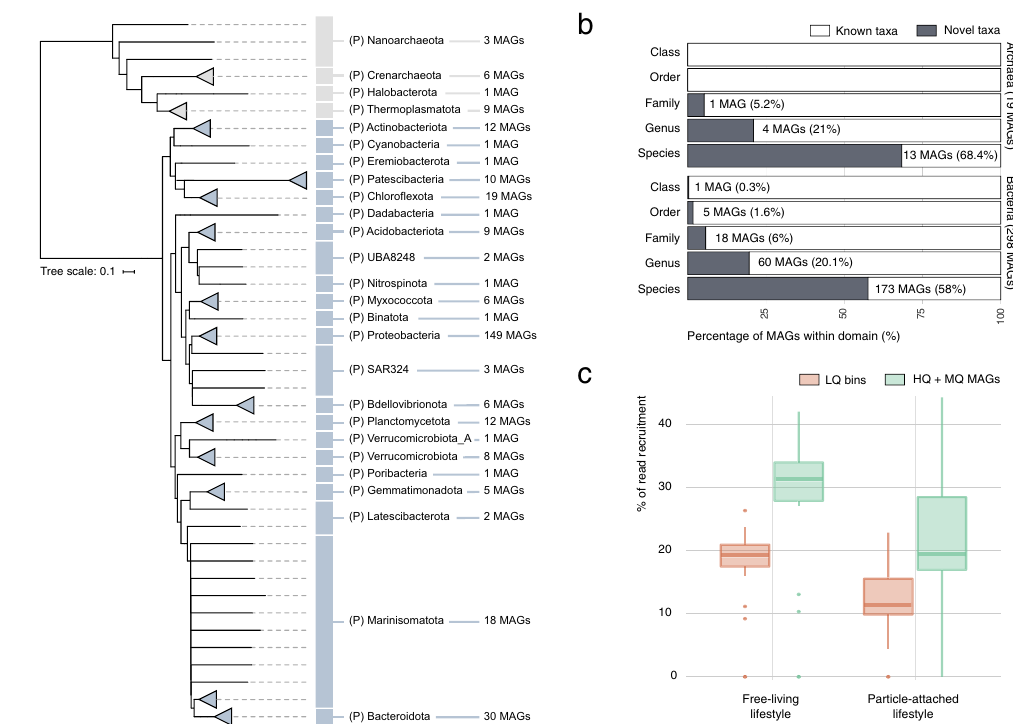
Fig. 5 Taxonomy and novelty of the Malaspina Deep MAGs catalog (MDeep-MAGs). a Phylogenomics-based taxonomic classi fi cation of the 317 MDeep-MAGs (i.e., high-quality bins) dataset obtained from co-assembling 58 bathypelagic ocean metagenomes. MAGs are displayed at the phylum (P = phylum) taxonomic level using the closest reference based on the Genome Taxonomy Database GTDB. b Stacked bar plot for novelty quanti fi cation of the Malaspina MDeep-MAGs ( X axis) according to their taxonomic ranks ( Y axis) for archaea and bacteria. The taxonomically unclassi fi ed portion is depicted in white and classi fi ed in gray. c Distribution of metagenomic reads ’ recovery by the low-quality metagenomic bins (LQ in orange) and the 317 MDeep- MAGs (that corresponded to medium quality (MQ) and high-quality (HQ) MAGs) reconstructed per sample in green. Samples are divided by lifestyle (free-living and